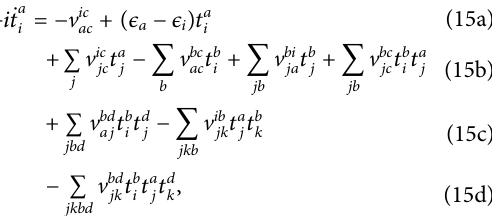
Frontiers in Chemistry |